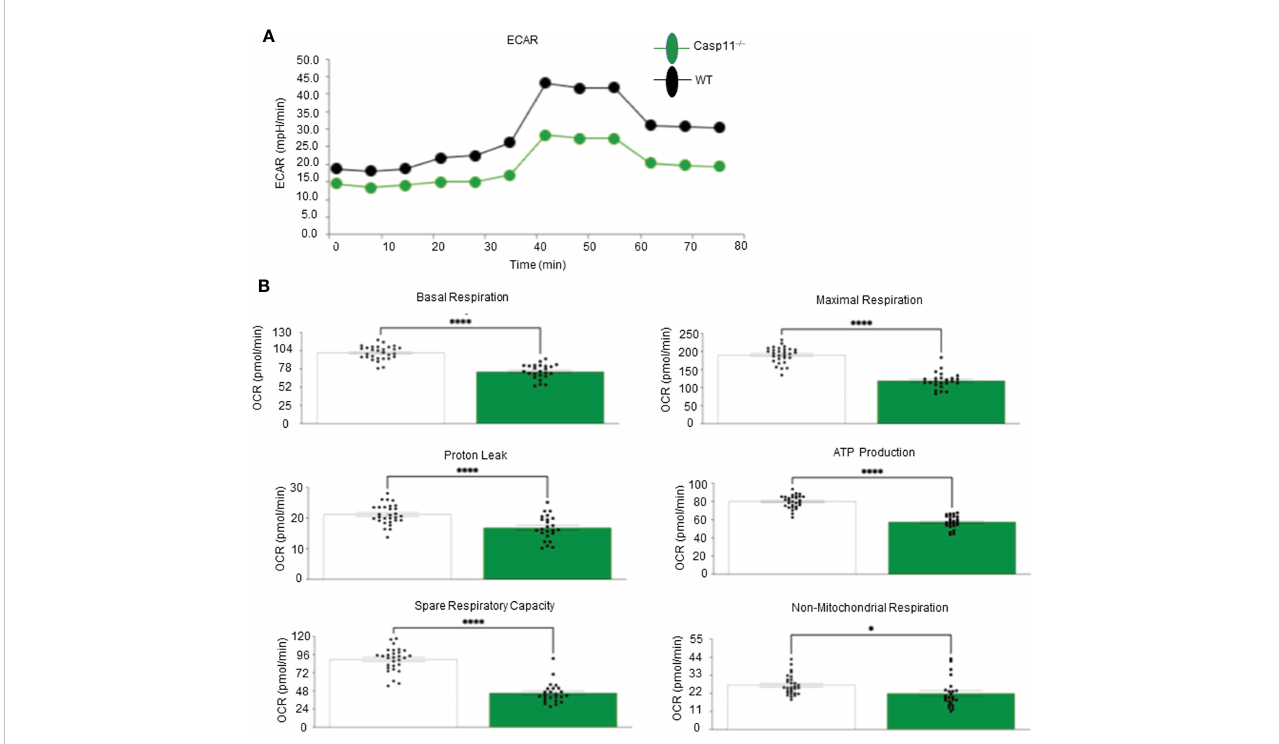
FIGURE 5 Caspase-11 signi fi cantly contributes to maintaining dual fuel bioenergetics- glycolysis and OXPHOS in macrophages potentially for cholesterol synthesis and trained immunity. Bone marrow macrophages were isolated from 3 WT and 3 Casp11 – / – mice and treated with palmitic acid (500 µM) for 8 hours then pulled for seahorse analysis. (A) Seahorse XF96 Extracellular Flux Analyzer to measure extracellular acidi fi cation rate (glycolysis) of Casp11 – / – vs WT BMDMs in palmitic acid supplemented medium. (B) Seahorse mitochondrial function assay of Casp11 – / – vs WT BMDMs in palmitic acid supplemented medium.*P < 0.0, ****p <